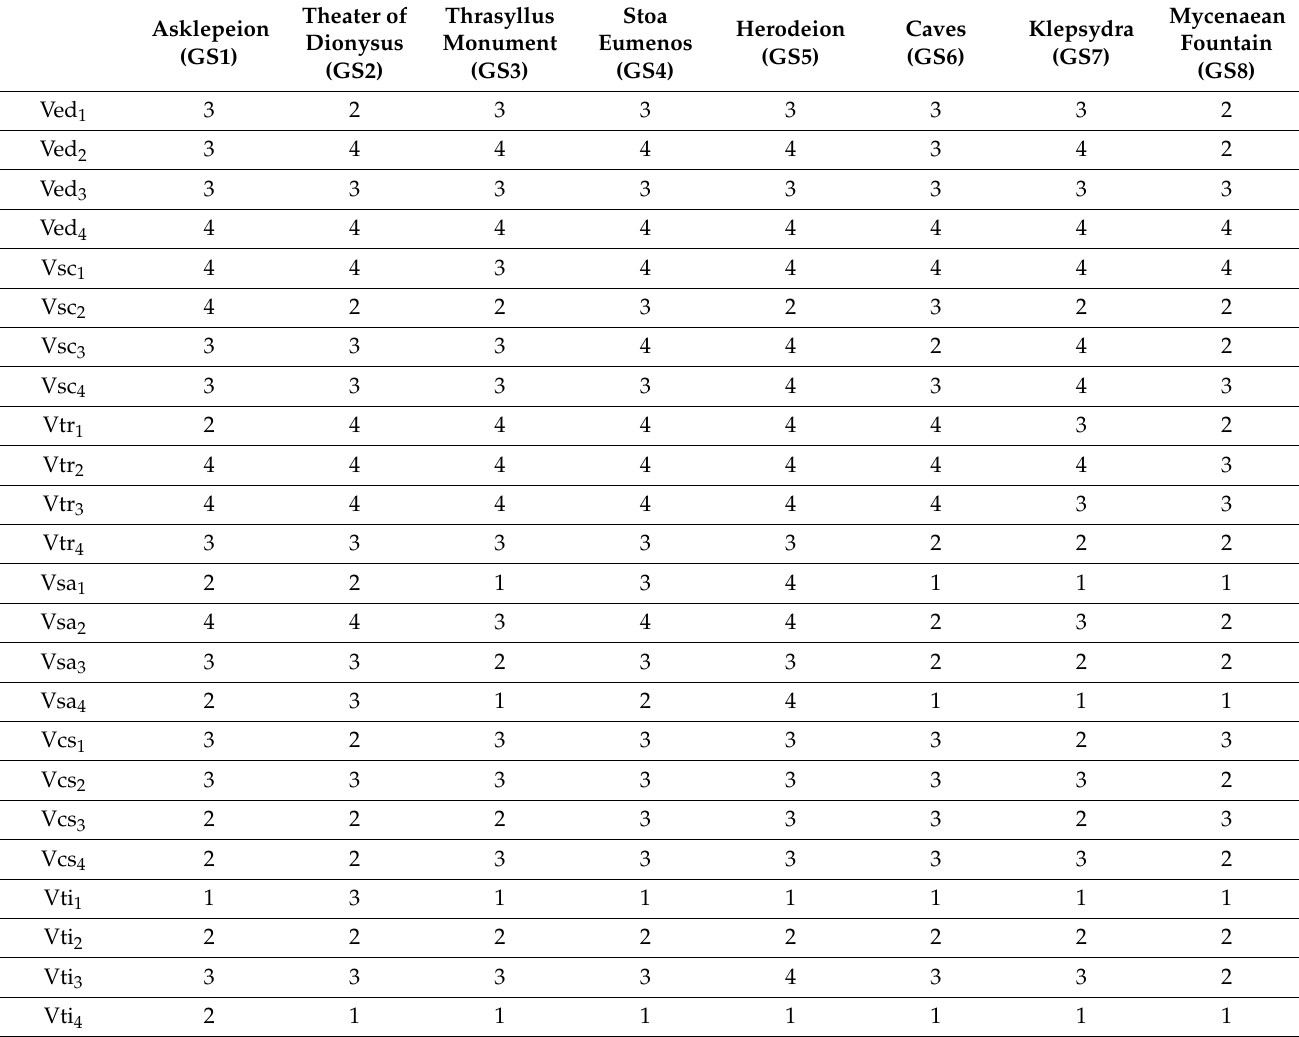
Table 7. Score of the sub-criteria for each assessment axis, for each geotope.